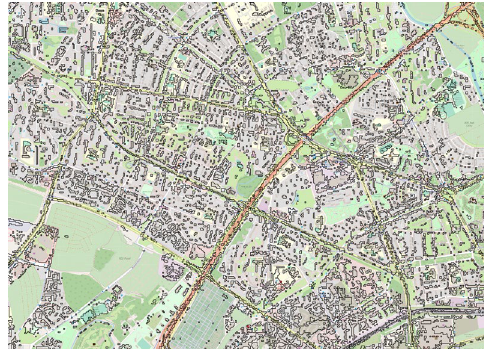
Fig. 5. Comparison of mapped impervious surface based on NDBI with Open street